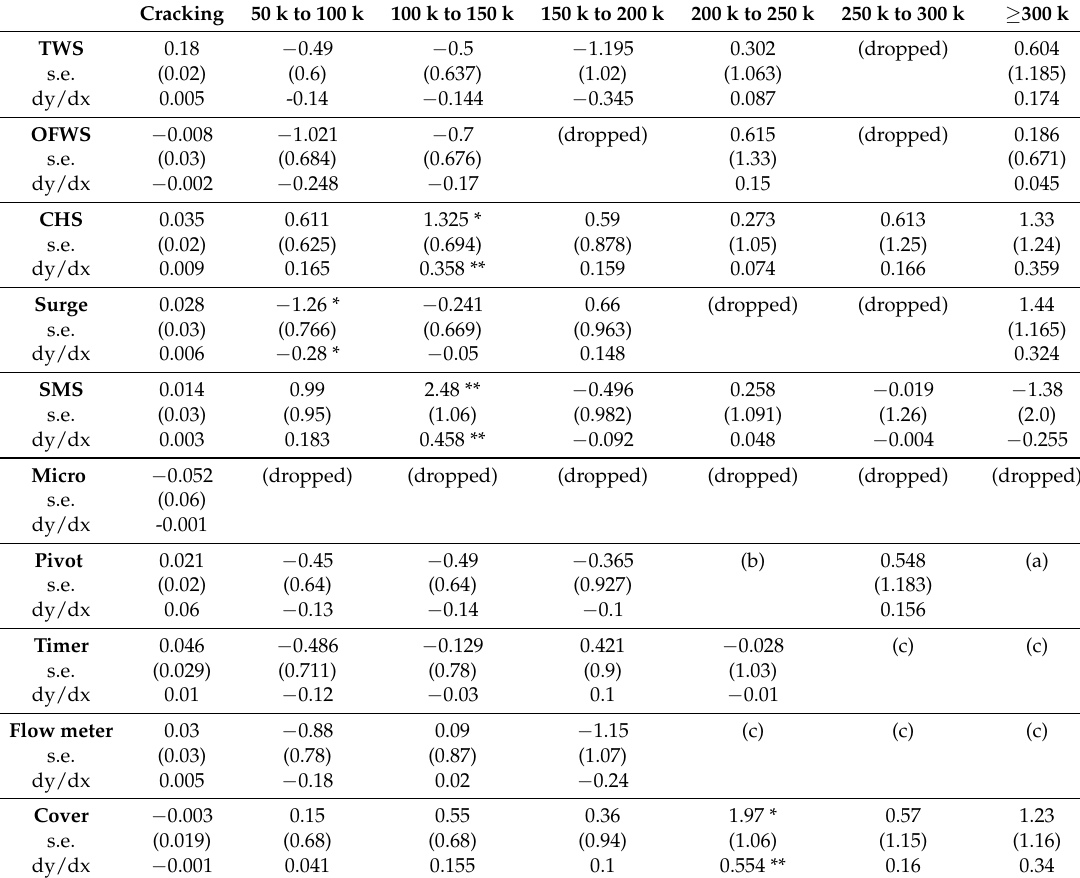
Table 7. Results from probit regressions (continued) on “cracking” soils and income